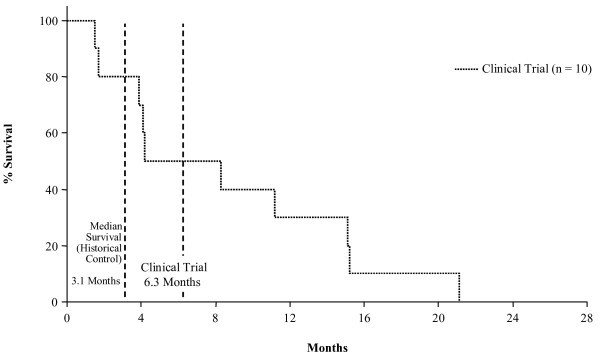
Overall survival of patients enrolled in trial compared with historical control. Median overall survival = 6.30 months (Trial), and 3.1 months (control).